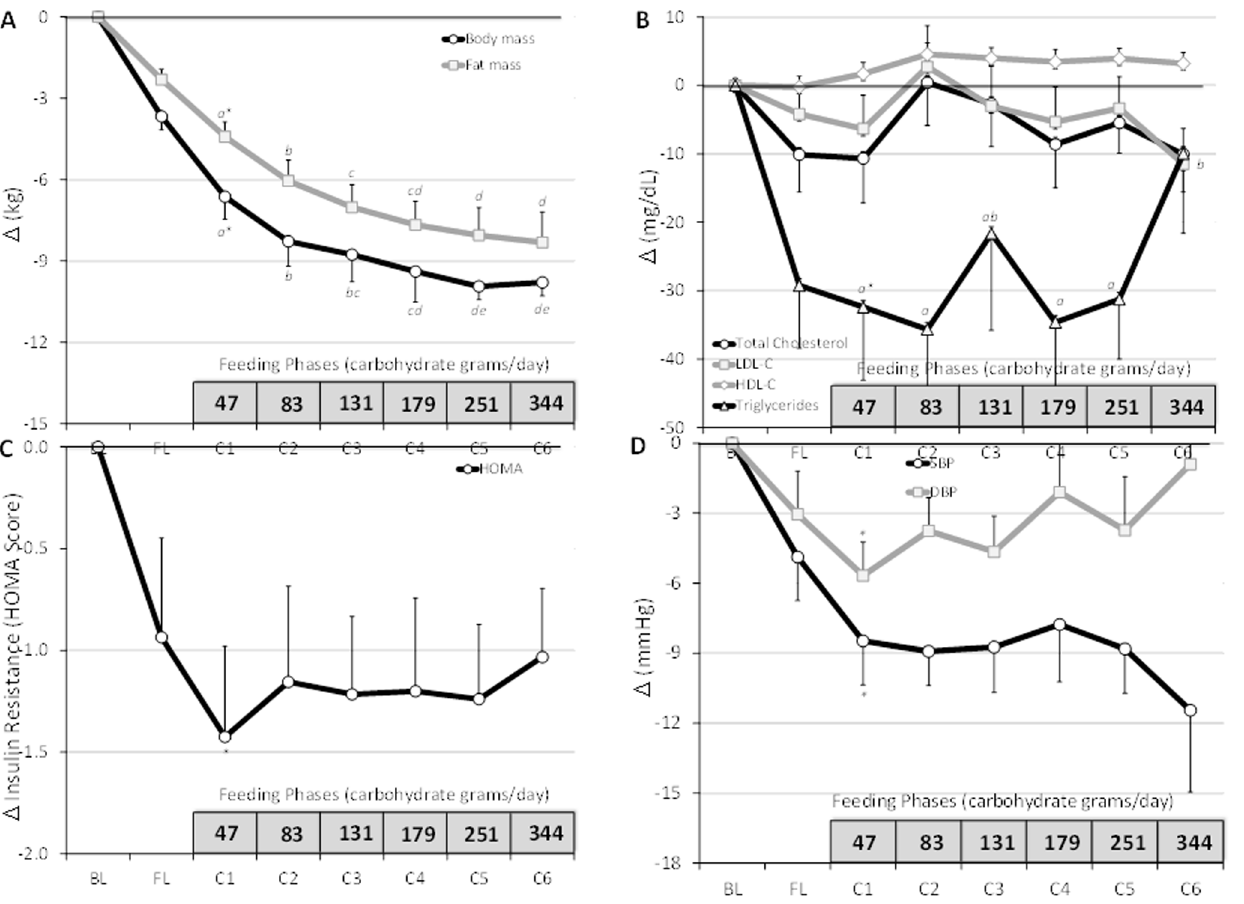
Figure 2. Cumulative change from baseline in (A) body mass and fat mass from dual-energy x-ray absorptiometry, (B) fasting lipoproteins, (C) insulin resistance determined from homeostatic model assessment (HOMA), and (D) blood pressure in 16 subjects who switched to a very low carbohydrate diet and then incrementally increased carbohydrate every 3 wk over six sequential phases (C1 R C2 R C3 R C4 R C5 R C6). BL 5 baseline, FL 5 free-living low-carbohydrate diet). Significant differences from Baseline vs C1 were determined by dependent t-test and indicated by an asterisk. Differences from C1 to C6 were determined by repeated measures ANOVA and Fisher’s LSD post hoc. Different letters at a time point indicate statistical